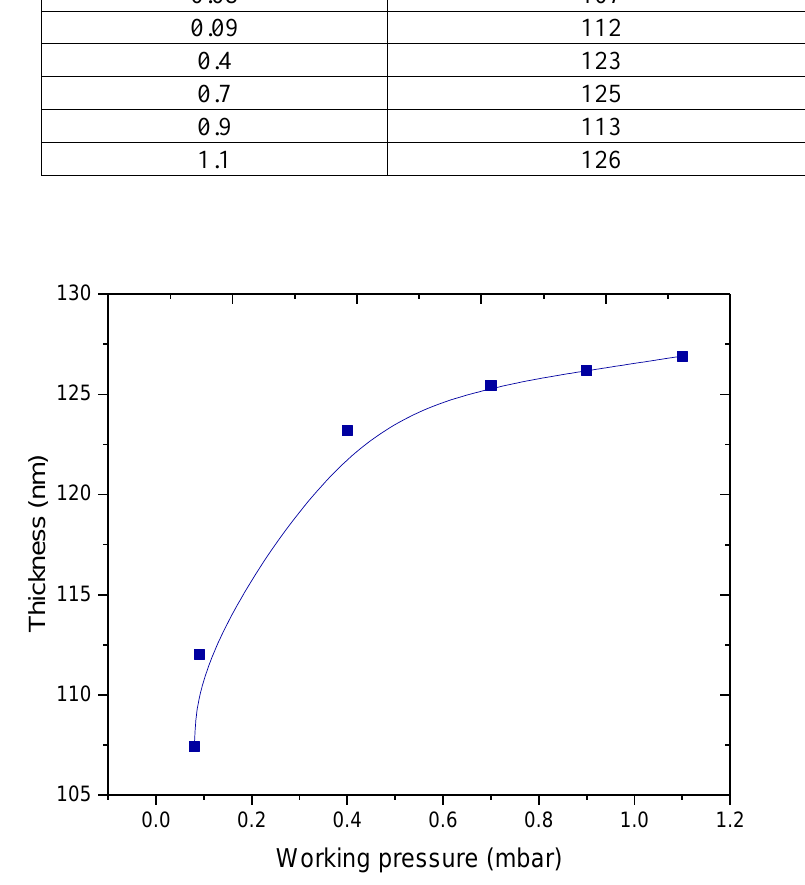
Fig. 5: Film thickness at different working